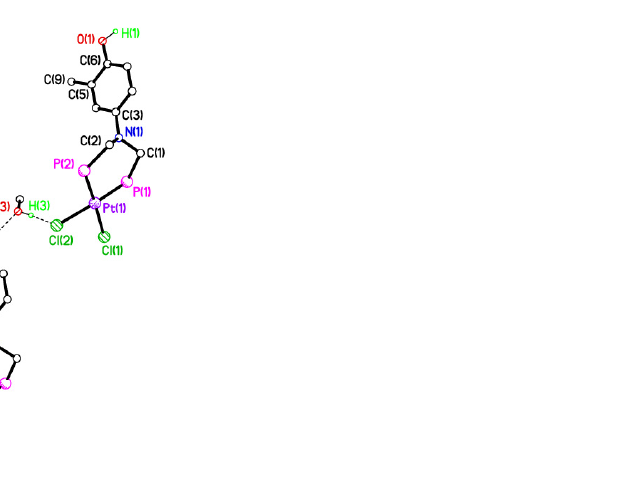
CHCl 3 · 1 CH 3 OH. Most H atoms, 2 2